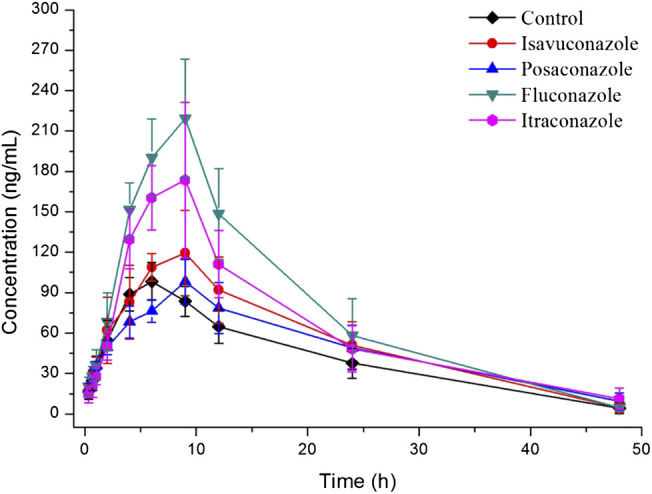
Mean plasma concentration-time profiles of fedratinib in different groups of rats after treated with 40 mg/kg fedratinib. Data are expressed as mean ± SD (n = 6).